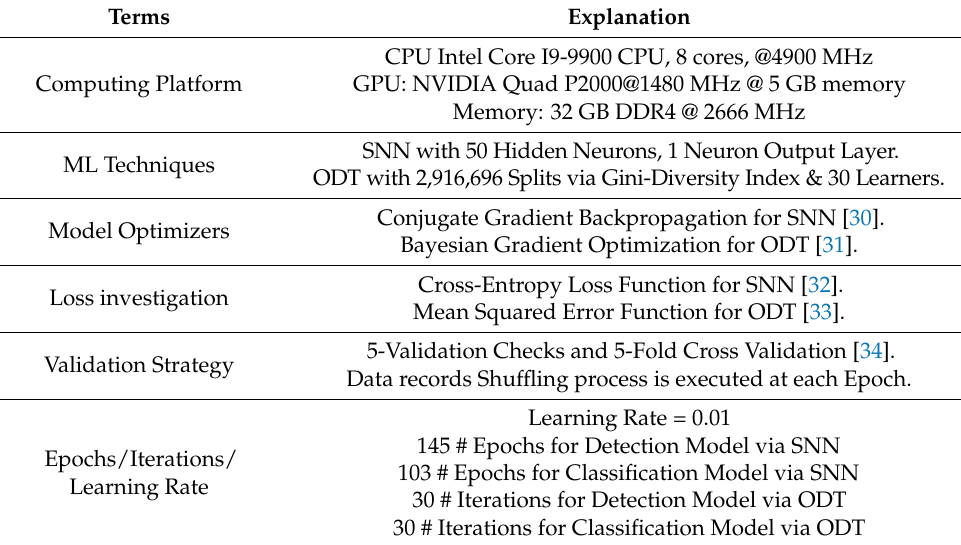
Table 2. Brief description of system development configurations and